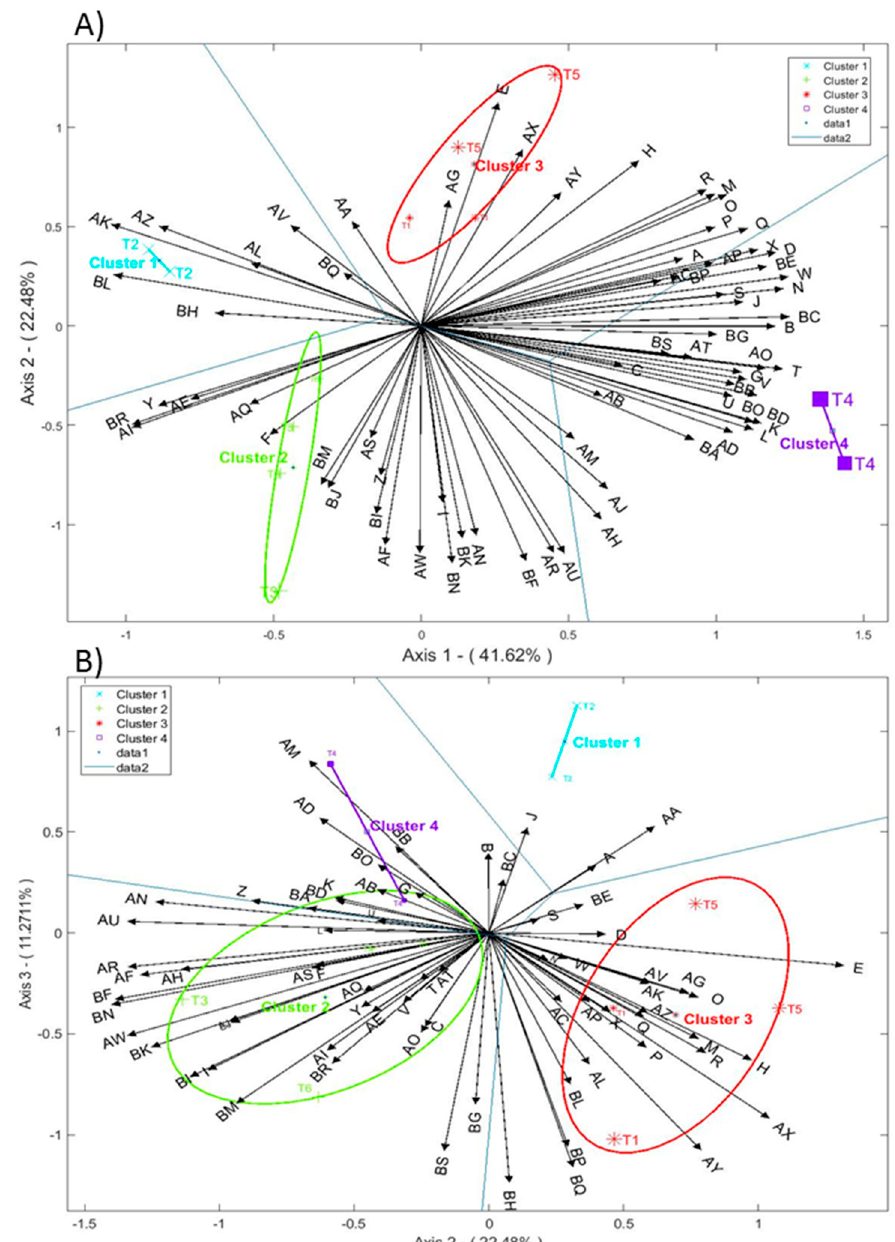
Figure 3. Biplot, including clustering and Voronoi borders, representing the projections of cases scores and variables loadings onto axis F1 vs F2 ( A ) and F2 vs F3 ( B ). Contributions of cases are proportional to the size of symbols and letters (see Table 2 for the meaning of symbols) while those of VOCs (see Table 2 for codes) are proportional to the length of their arrows.